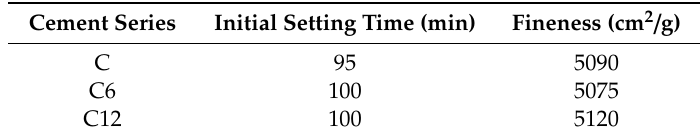
Table 4. Strength characteristics of tested mortars. Table 3. Initial setting time and fineness of tested cements.